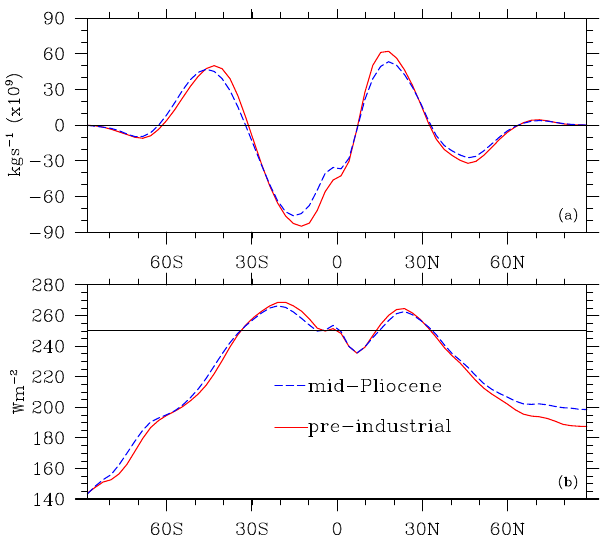
Fig. 6. (a) : latitudinal cross-section of the mass stream function at 500hPa in the pre-industrial and mid-Pliocene. (b) : zonal mean outgoing longwave radiation in the pre-industrial and